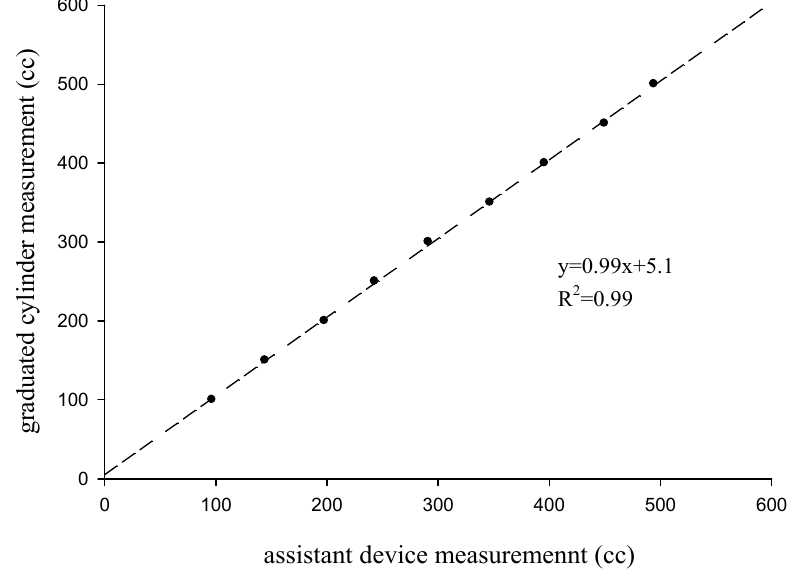
Figure 6. The regressive curve of urine volume measurement between CIC assistant device and graduated cylinder.